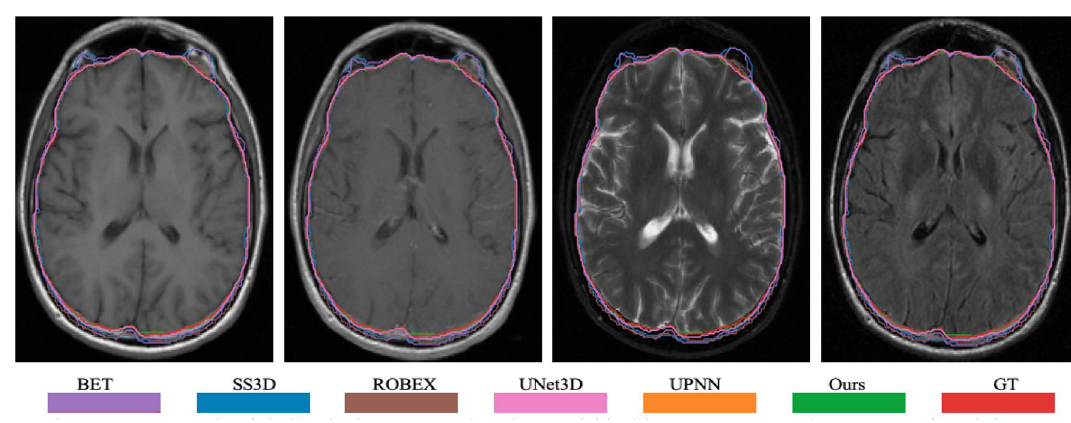
Figure 4. An example of skull stripping contours in color overlaid with T1, T1ce, T2, and T2-FLAIR (from left to right) using different methods/tools (color image for a better visualization). GT is the ground truth.